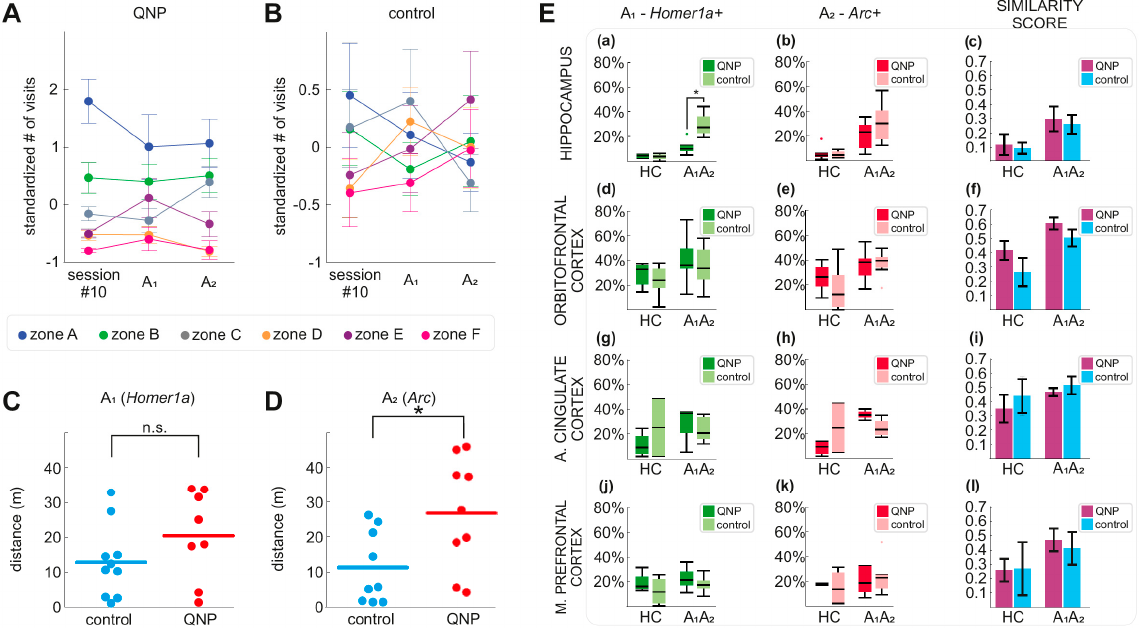
Figure 2. Zone visits, locomotor activity and IEG expression in HPC, OFC, ACC and mPFC during sessions A 1 and A 2 . Standardized values of visits to zones in quinpirole (QNP) treated ( A ) and control rats ( B ). ( C ) Locomotor activity in QNP treated rats ( n = 9) and control rats ( n = 9) in session A 1 were not significantly different. ( D ) In session A 2 , QNP treated rats were significantly more active than control rats ( p = 0.025). ( E ) Immediate early genes (IEG) expression and similarity scores of IEG expressing neurons in the hippocampus ( a – c ), the orbitofrontal cortex ( d – f ), the anterior cingulate cortex ( g – i ) and the medial prefrontal cortex ( j – l ). Panels ( a ) and ( b ) show that the expression of Homer1a and Arc was significantly lower in quinpirole (QNP) treated rats than in control rats exploring the arena (A 1 A 2 ) ( p < 0.05) in the hippocampus. There were no significant differences in IEG expressions or in similarity scores for treatment and environment in any other brain region. HC denotes home cage groups (QNP: n = 6); control: n = 5). The asterisk denotes significant between-group differences at p < 0.05.